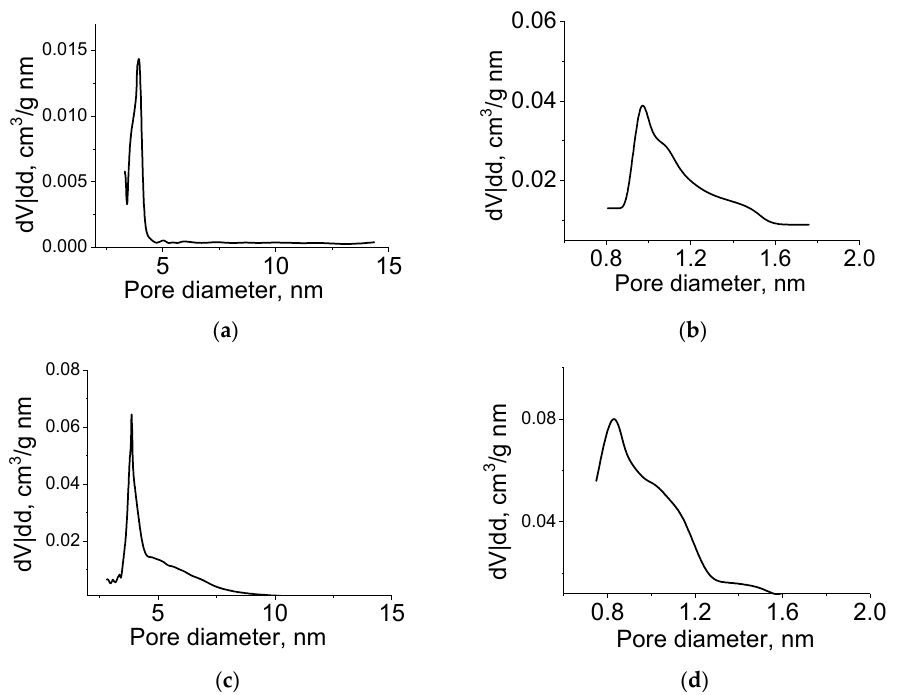
Figure 9. Meso- ( a , c ) and micropore ( b , d ) size distribution of molybdenum carbide synthesized from molybdenum blue xerogels using ( a , b ) glucose (G-5, R/Mo = 5) and ( c , d ) hydroquinone (H-4, R/Mo = 4), calcined at 900 °C in an inert atmosphere.